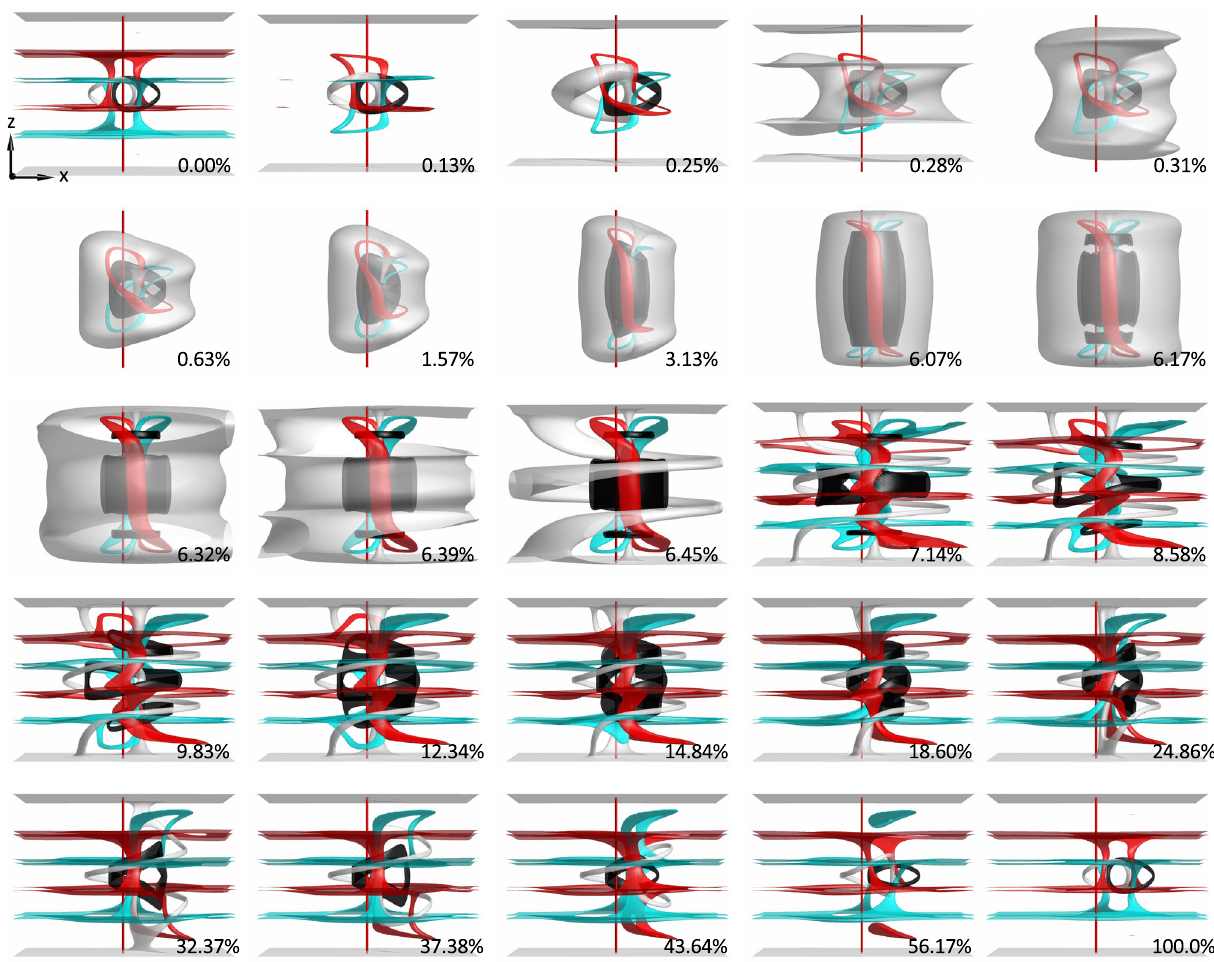
Fig. 5 Preimage visualization of the simulated geometric transformation of a Hopf soliton. Simulated geometric inter-transformation of a Hopf soliton from the heliknoton embodiment in the helical background to the hop fi on embodiment in the uniform background, and back to the heliknoton embodiment visualized by preimages (white: þ ^ z , black: (cid:5) ^ z , red: þ ^ x , cyan: (cid:5) ^ x ). The corresponding percentage of the total inter-transformation time in simulations is labeled in each panel. The conserved linking number of each pair of preimages demonstrates the conserved fi eld topology of the Hopf soliton during the transformation